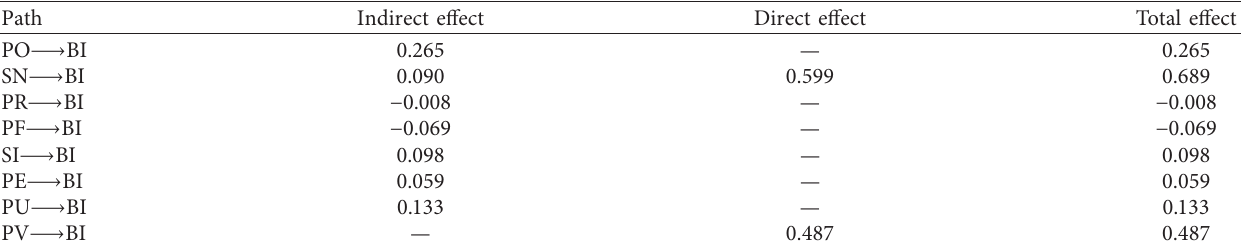
Figure 2: Results of SEM analysis. Note: ∗ p < 0 . 1; ∗∗ p < 0 . 05; and ∗∗∗ p < 0 . 001. Table 7: Indirect effect, direct effect, and total